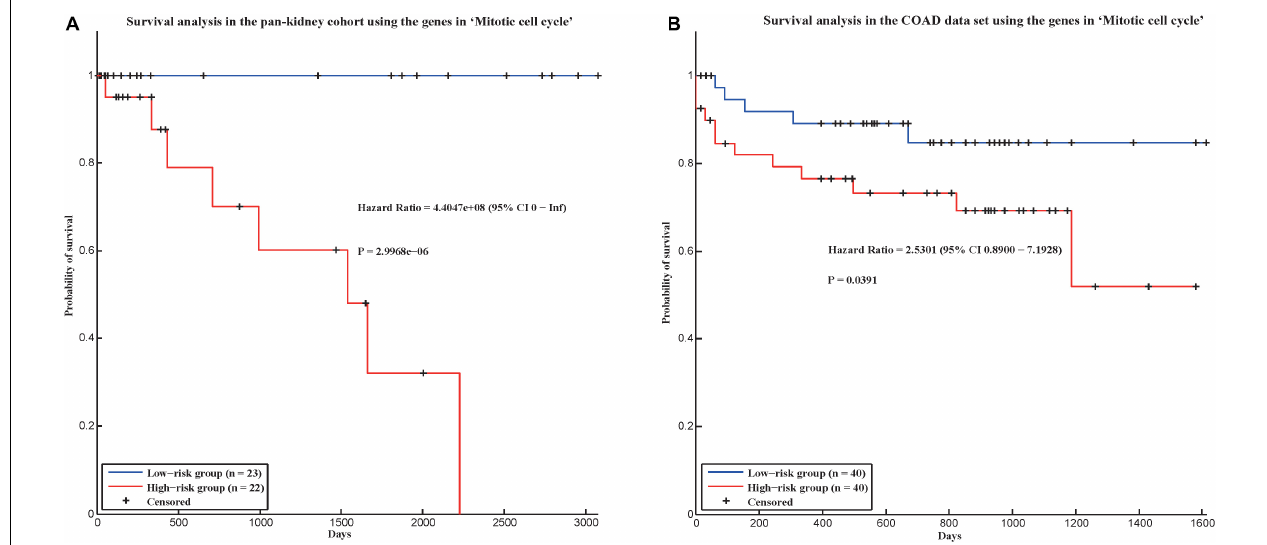
FIGURE 4 | Survival analysis in two validation cohorts using the genes in “Mitotic cell cycle.” (A) Pan-kidney cohort and (B) COAD data set.